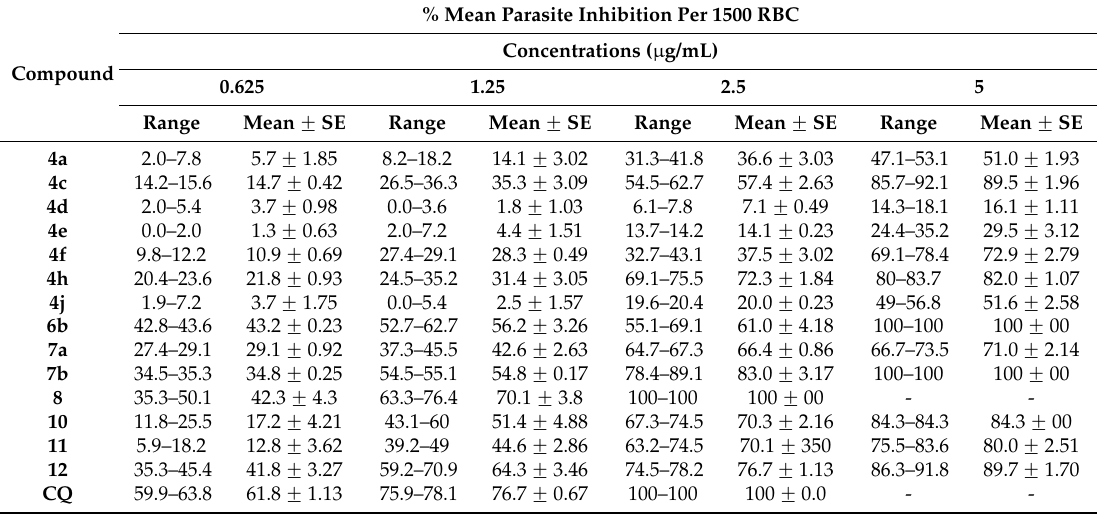
Table 2. % Parasite inhibition of Plasmodium falciparum ( % Mean Parasite Inhibition per 1500 RBC) of compounds 4b , g , i